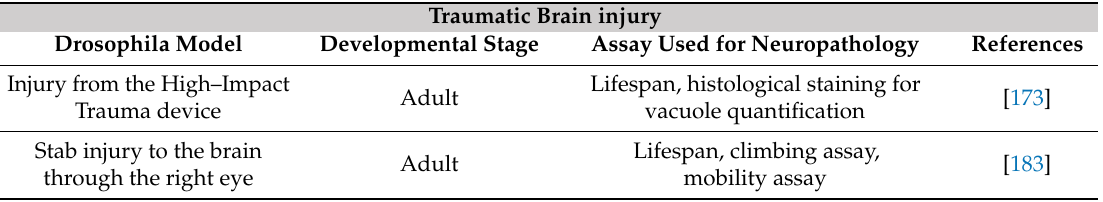
Table 8. Drosophila models of neurodegenerative traumatic brain